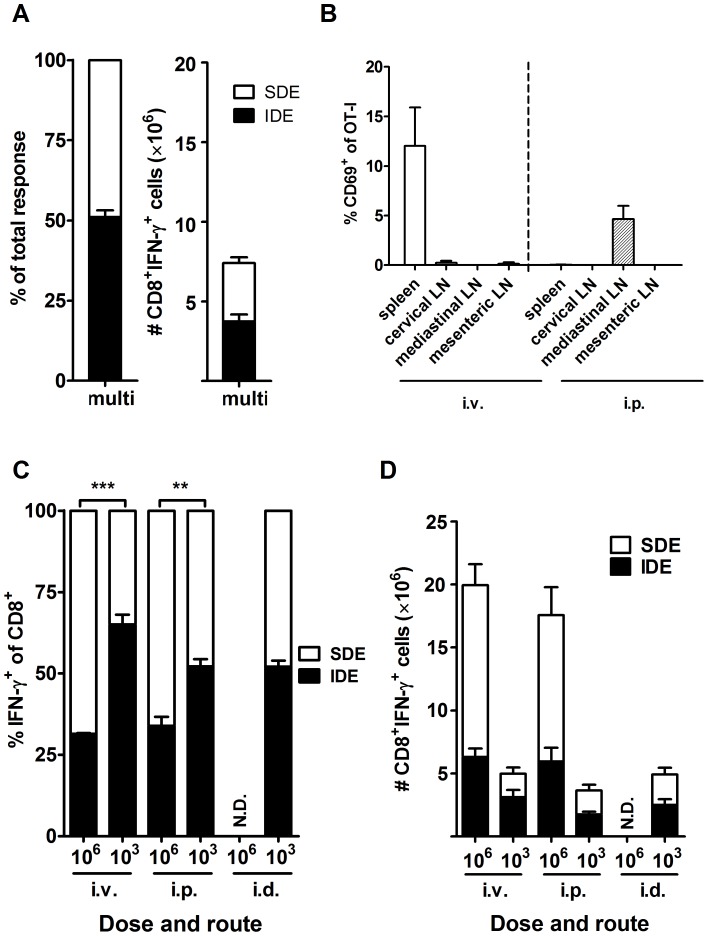
Immunodominance is reduced by robust priming in the spleen.A) CD8+ T cell responses to 15 VACV epitopes were measured by intracellular staining of IFN-γ seven days after infection with 1×106 PFU of VACV WR in total spread equally across four peripheral sites (left and right ear pinnae, i.d. and shanks, s.c.). The fraction of the total measured response accounted for by the IDE-specific and the sum of SDE-specific CD8+ T cells is shown on the left. On the right, responses are again broken down into IDE and SDE, but shown as total numbers of CD8+IFN-γ+ cells per spleen. Mean and SEMs of 5 mice from two experiments are shown. B) Priming of OT-I CD8+ T cells as demonstrated by upregulation of CD69 expression in the lymphoid organs shown 24 hours after infection with 1×103 PFU (low dose) of VACV NP-S-GFP by i.v. or i.p. injection (as for figure 3B). Data are from more than two experiments; 4 mice for i.p. and 3 for i.v. route. C-D) CD8+ T cell responses to 15 VACV epitopes in mice infected with 1×103 or 1×106 PFU of VACV WR by the routes shown, as described previously. Data are from more than one experiment and numbers of mice were: i.v. 106 = 3, 103 = 7; i.p. 106 = 5, 103 = 18; i.d. 106 = not done (N.D.), 103 = 11. C) Data shown are the fraction of the total measured response accounted for by the IDE-specific and the sum of SDE-specific CD8+ T cells. D) Responses are again broken down into IDE and SDE, but shown as total numbers of CD8+IFN-γ+ cells per spleen. Statistical significance denoted with p value over appropriate bars.